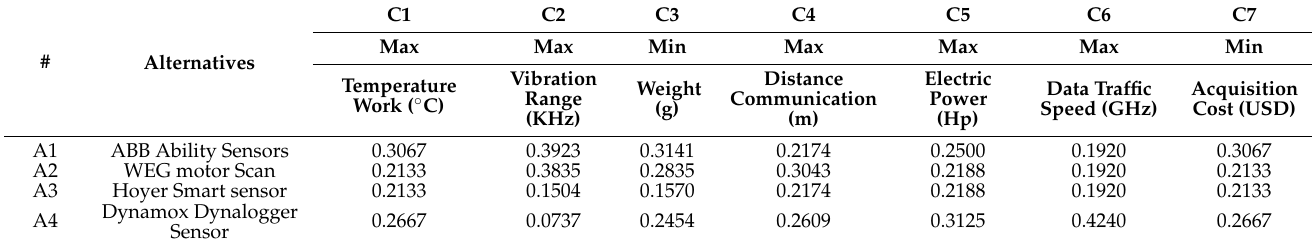
Table 9. Average criteria—standard deviation—Gaussian factor—Step 5.